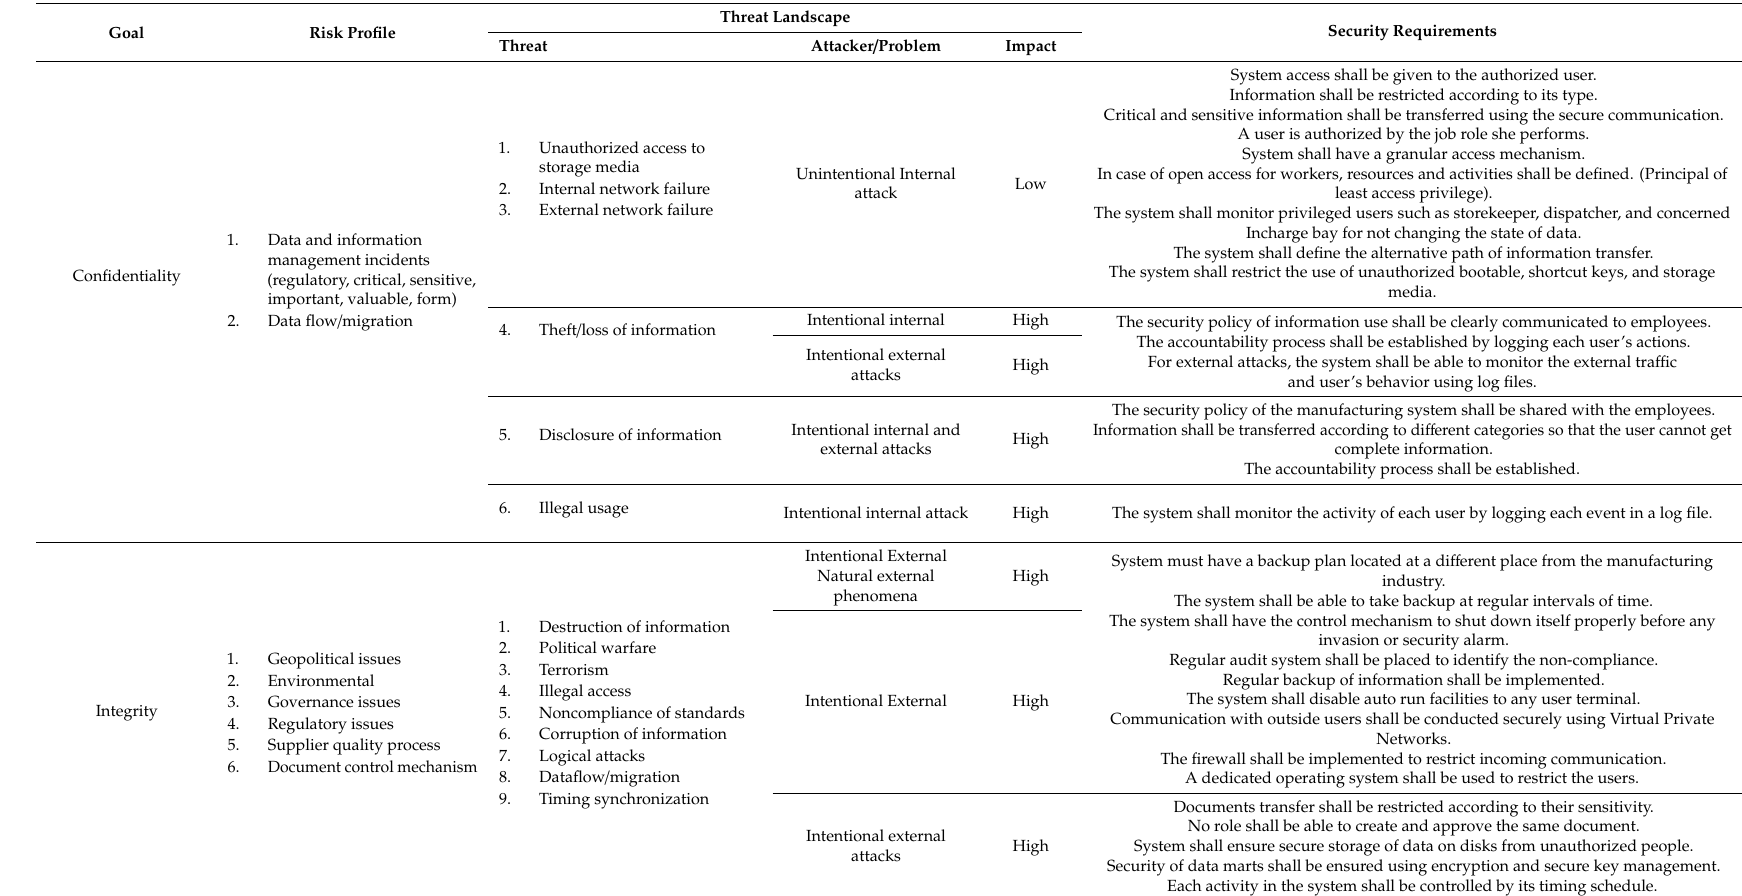
Table 5. Elicited security requirements along with risk analysis using threat-based security requirements